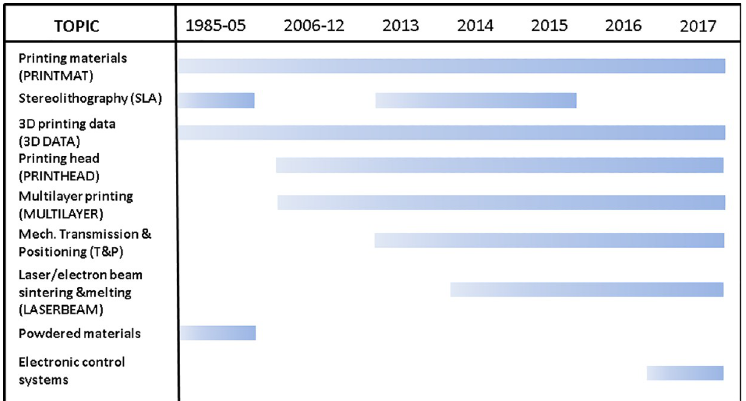
Fig 11. List of technology fronts. Labels of the technology fronts detected in the sub-datasets and the time span each technology front is